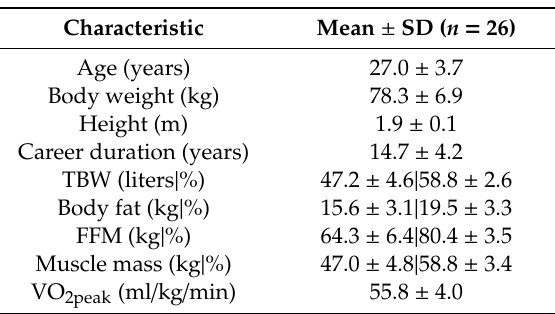
Table 1. Participants’